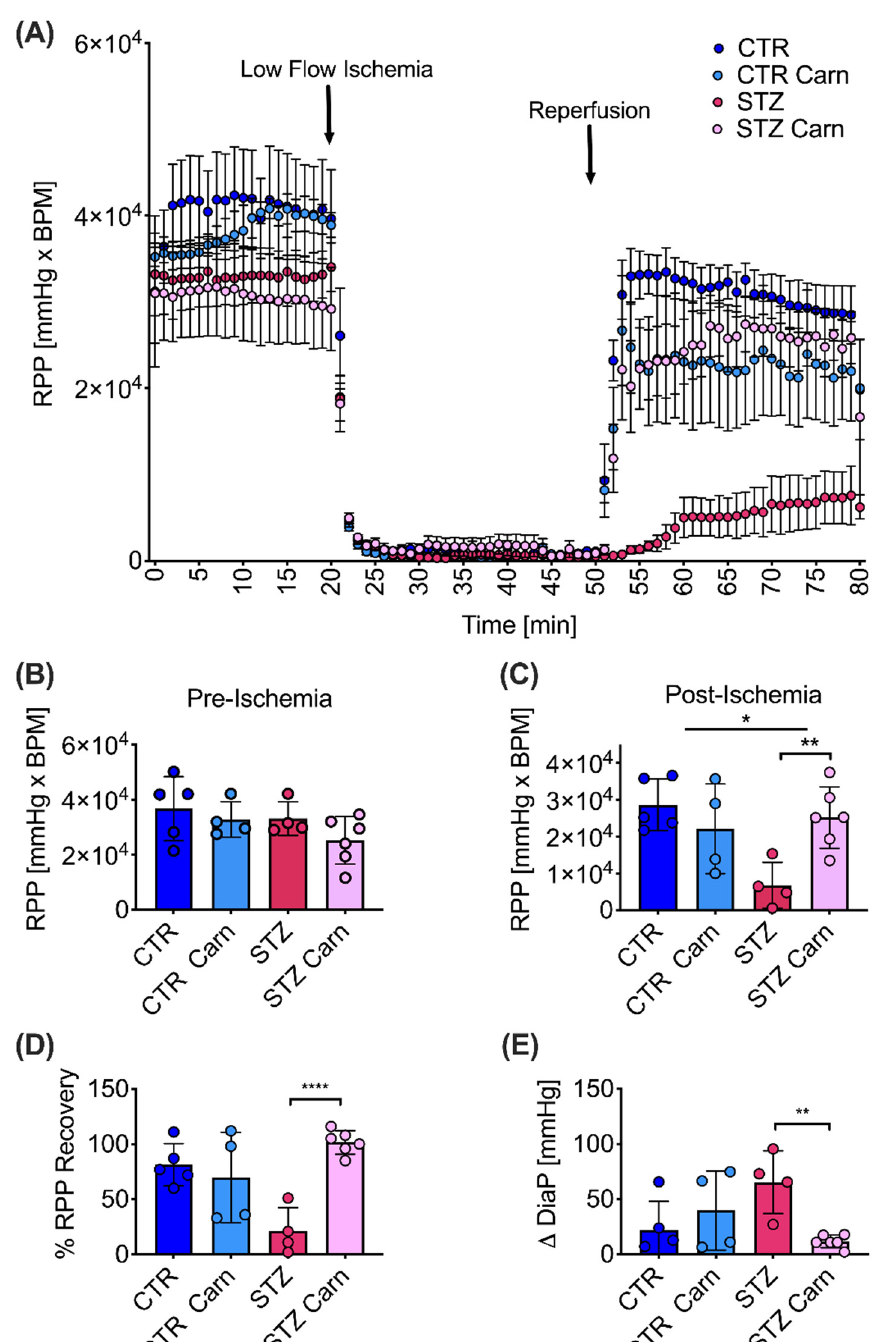
Figure 5. Carnitine rescues cardiac function in diabetes after low-flow ischemia in Langendorff perfused hearts. ( A ) Rate pressure product (RRP) over time: pre-ischemia (t = 1:20 min), low flow ischemia (t = 21:50 min), post ischemia (t = 51:80 min). ( B ) Rate pressure product (RRP) pre-ischemia. ( C ) Rate pressure product (RRP) post-ischemia. ( D ) Percentage recovery between pre-ischemia (t = 10:20 min) and post-ischemia (t = 70:80 min). ( E ) Difference between post-ischemia and pre-ischemic diastolic pressure ( ∆ DiaP). Diastolic pressure was set during pre-ischemia to 4–8 mmHg. Data are presented as mean ± SD. Two-way ANOVA, if an interaction was found to be significant, the effect of L-carnitine on control and diabetes was evaluated using Sidak’s multiple comparison test. Significant differences are represented by ‘*’, with * p < 0.05, ** p < 0.01, **** p < 0.0001.